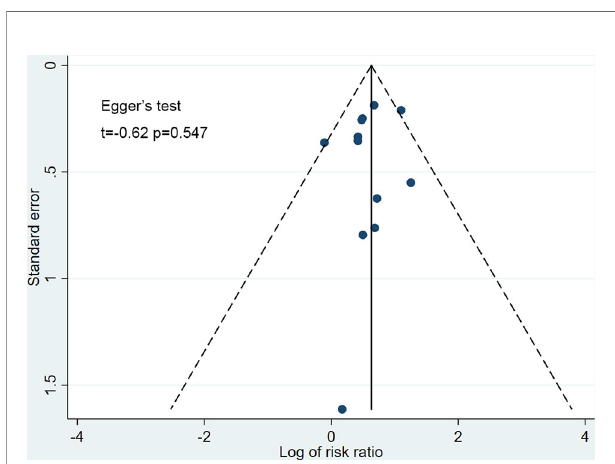
FIGURE 7 | Funnel plot for publication bias. Scatter plot reporting risk ratio of the studies testing SGLT-2 inhibitors plus sulfonylureas compared with placebo plus sulfonylureas (horizontal axis) against their standard error (vertical